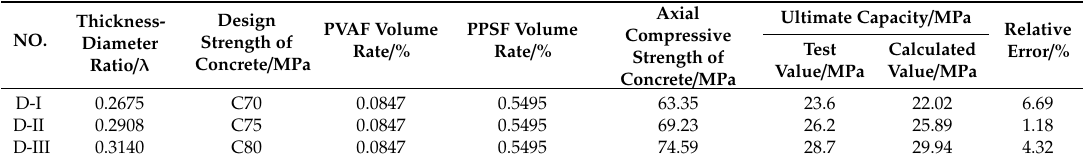
Table 5. The ultimate capacity of the shaft lining structure in the model test.